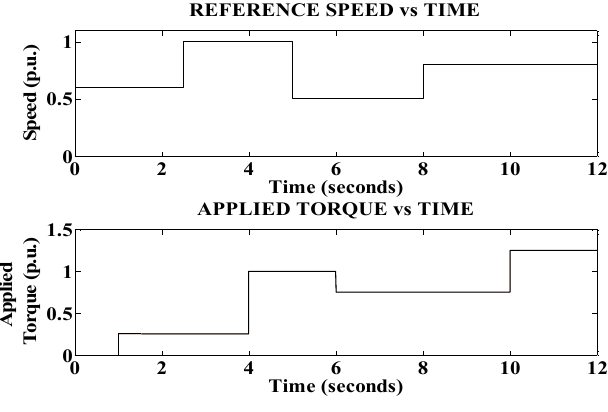
Figure 6. Speed and load torque references.